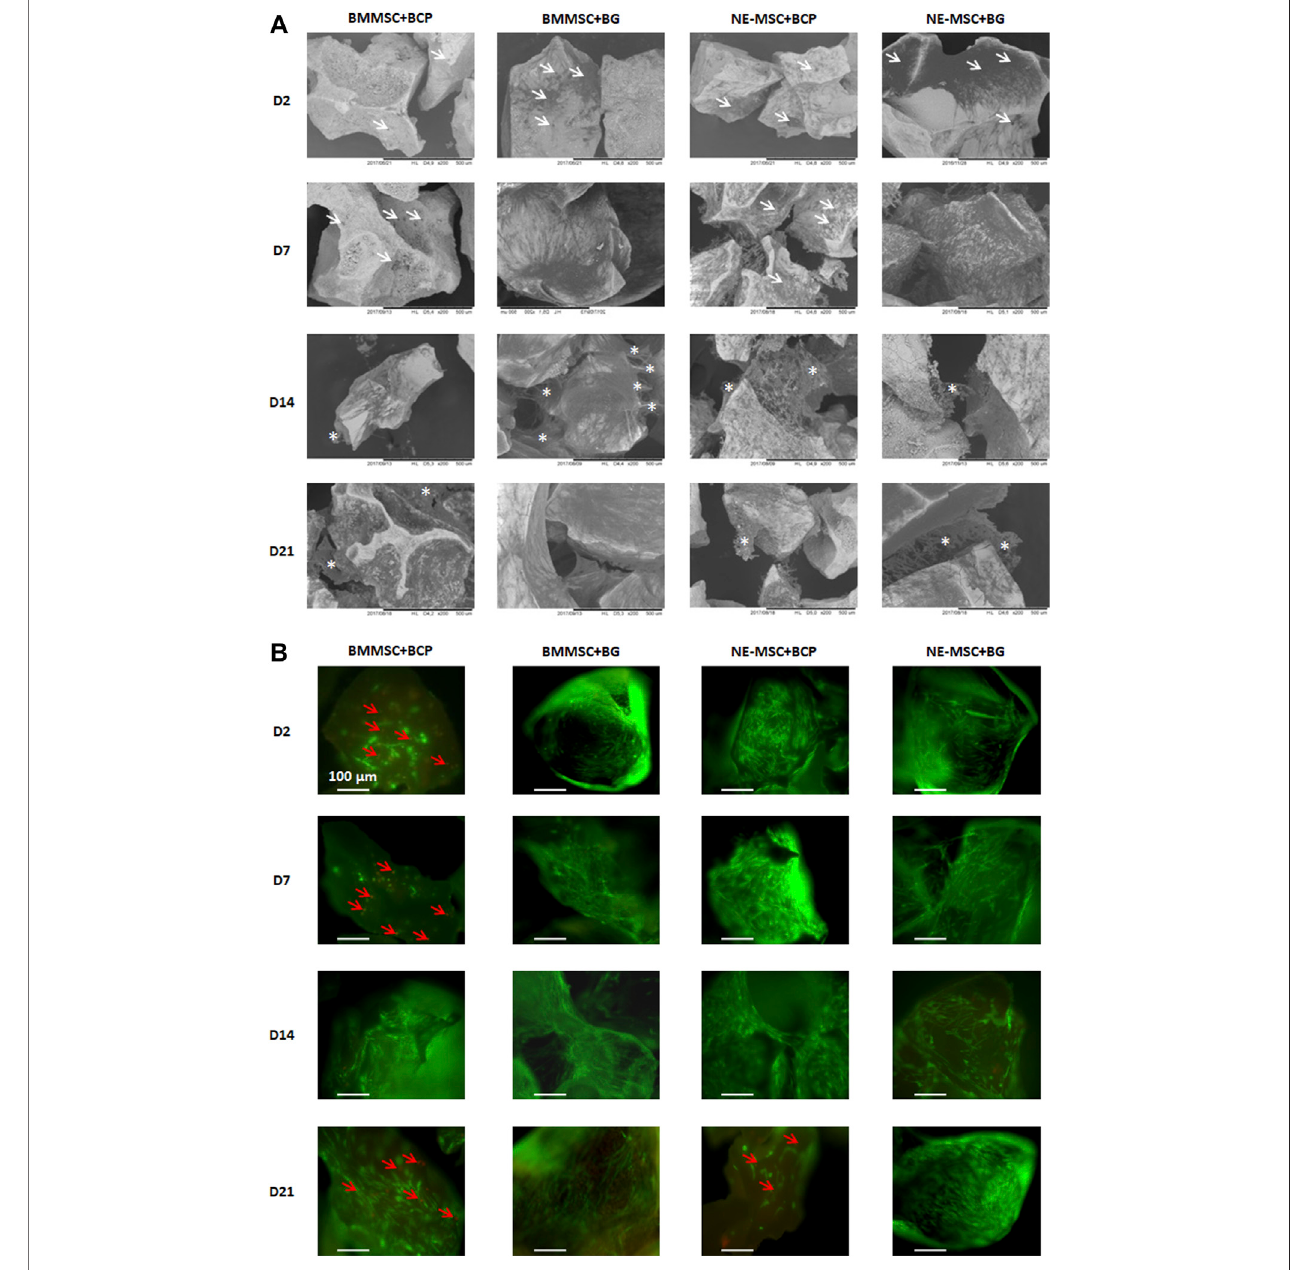
FIGURE 3 | (A) Comparative adhesion of the two MSC types on biomaterials using SEM. Both BM-MSCs and NE-MSCs rapidly adhere to BCP and BG (white arrows) and synthesize an extracellular matrix at D14 (white asterisks). (B) Comparative viability of the two MSC types on biomaterials using fl uorescent stains for living (green) and dead (red) cells (red arrows). BG, and not BCP, induces cell death, as early as D2 for BM-MSCs, and only at D21 for NE-MSCs.